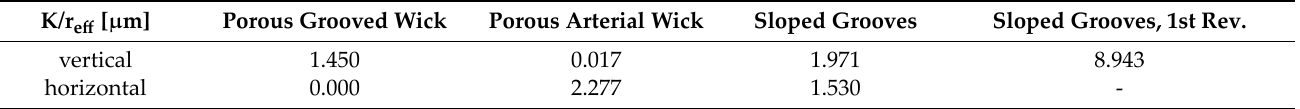
Table 4. Performance of the alternative wick concepts.